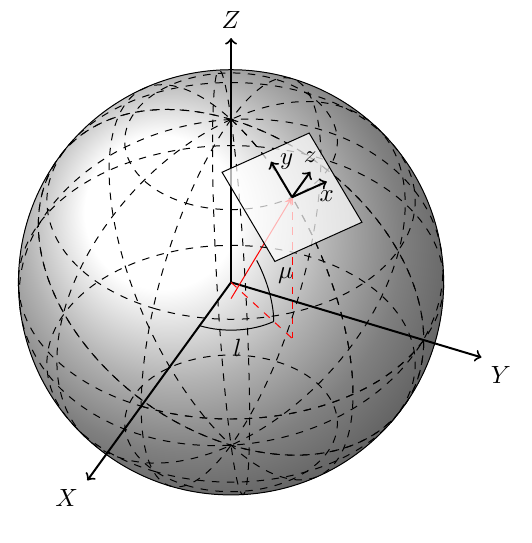
Figure 3: The Earth-Centered Earth-Fixed (ECEF) frame with axes X , Y , Z , and the East- North-Up (ENU) with axes x , y , z . The ori- gin of ENU frame is typically represented in terms of the reference ellipsoidal parameters longitude l , and geodetic latitude µ .